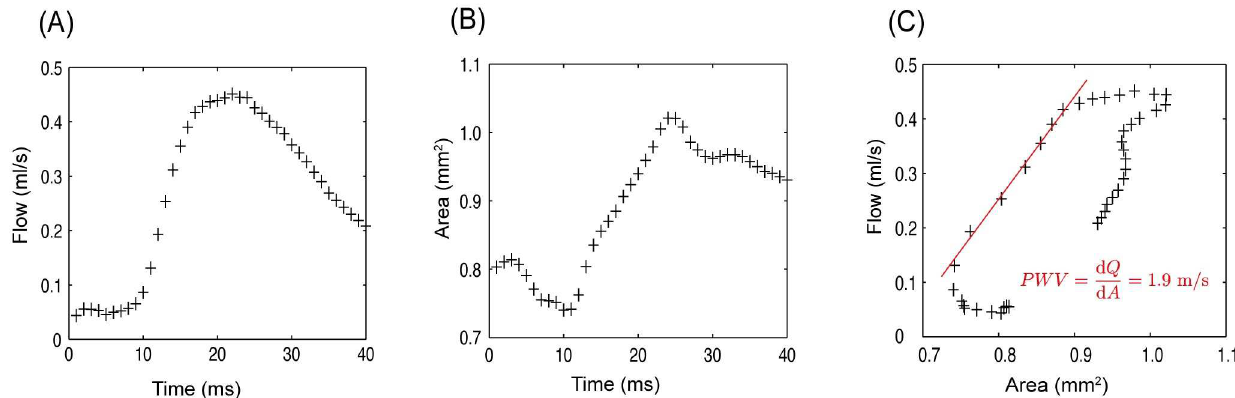
Fig 6. Determination of local PWV. Local PWV is assessed by simultaneously recording flow ( A ) and cross-sectional area ( B ) through an imagingslice perpendicular to the upper abdominal. The slope of the flow/areaplot ( C ) represents the local PWV at the examinedlocation (exemplarily dataset shownfor a WT